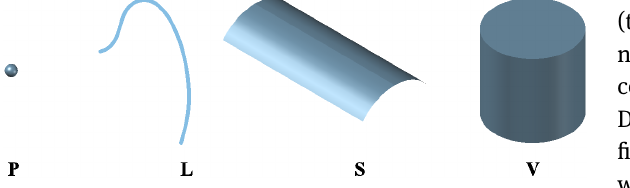
Figure 3: The four space elements and their notations.